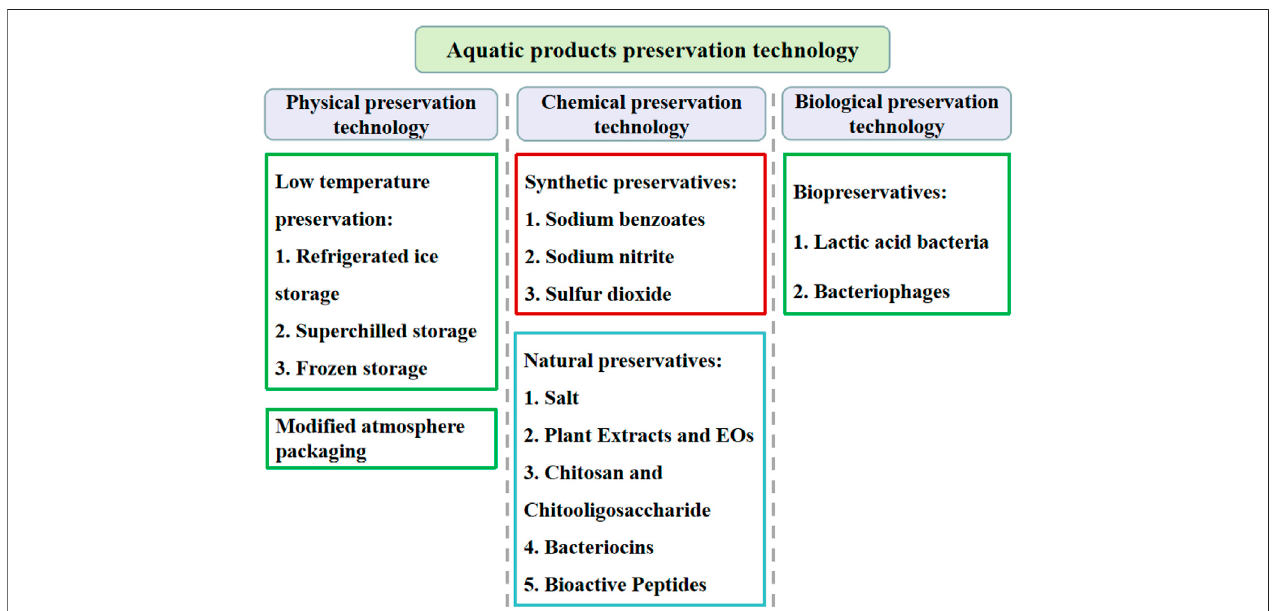
FIGURE 5 | Classi fi cation of the aquatic products preservation